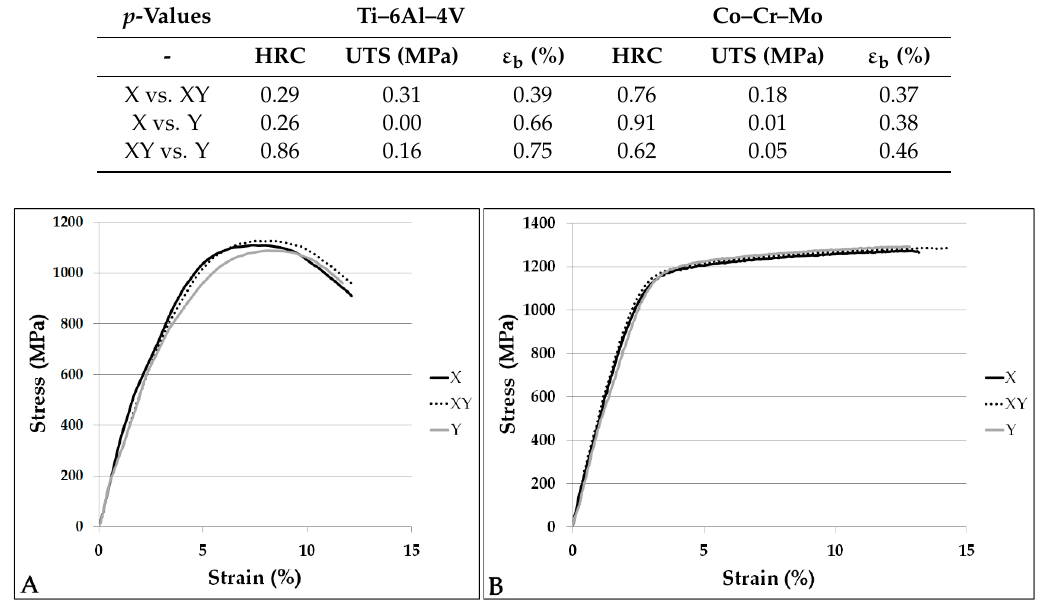
Figure 6. Example stress–strain curves of the Ti–6Al–4V ( A ) and Co–Cr–Mo ( B ) specimens built in the three orientations. three